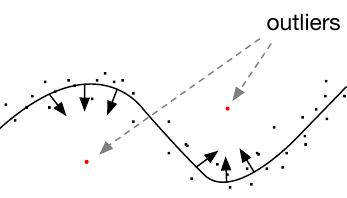
Figure 6. The example of the